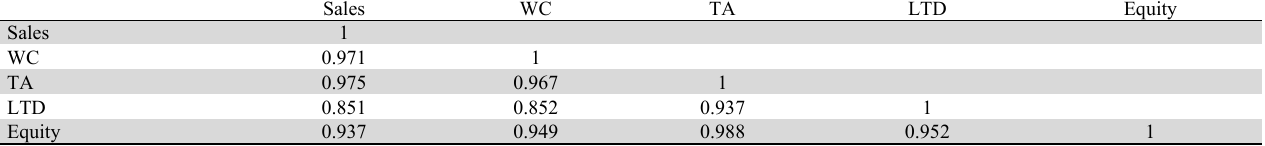
Source: Multiple correlation calculation is based upon the values given in the table 2.